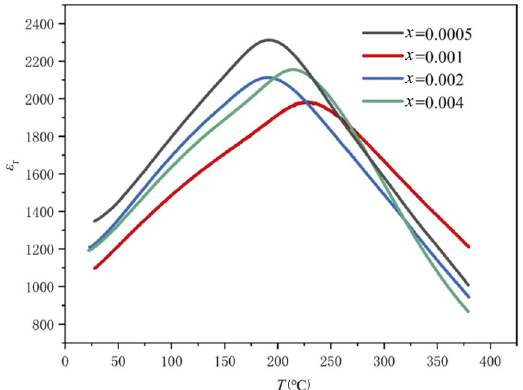
Fig. 8 Dielectric permittivity ε r as a function of temperature for the KNNS–0.04BNKZ– x Sm ( x = 0.0005, 0.001, 0.002, and 0.004)